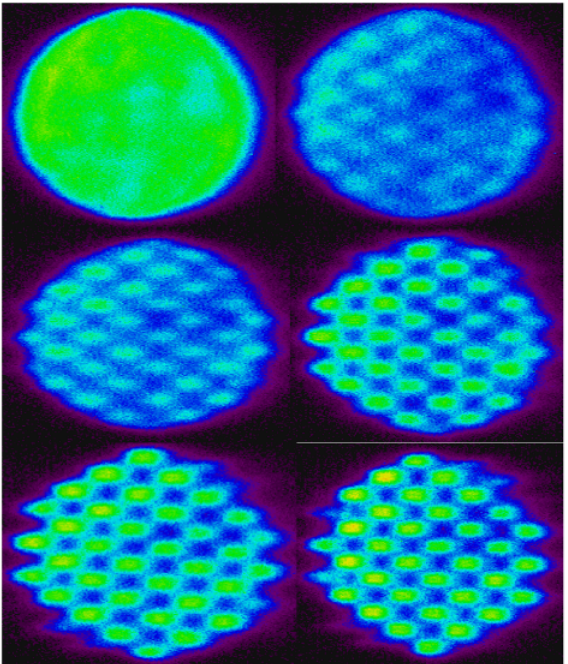
FIG. 5. (Color) Images of a noncylindrically symmetric laser with different rms nonuniformities. The rms nonuniformity for each image is calculated as follows. Top left: 7.3%; top right: 11.2%; middle left: 15%; middle right: 28%; bottom left: 33%; bottom right: